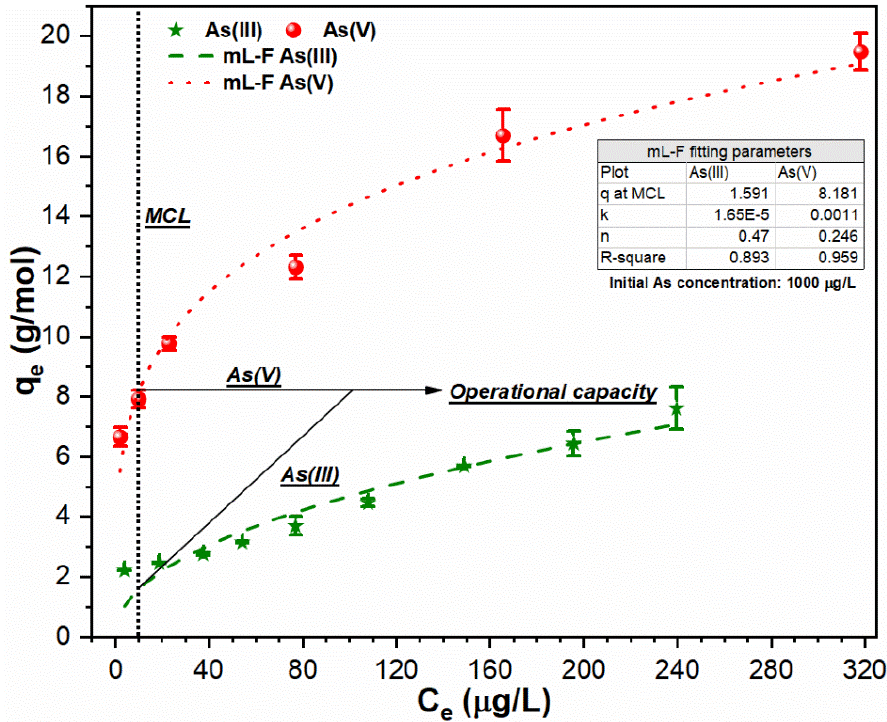
Figure 5. Sorption of As (III, V) species using mL-F model onto FHO surface at conditions: optimum pH of 7; temperature of 25 ◦ C; FC dosage of (As (III): 0.1–0.45 mM; As (V): 0.035–0.15 mM) and initial As loading of 1000 µg/L.